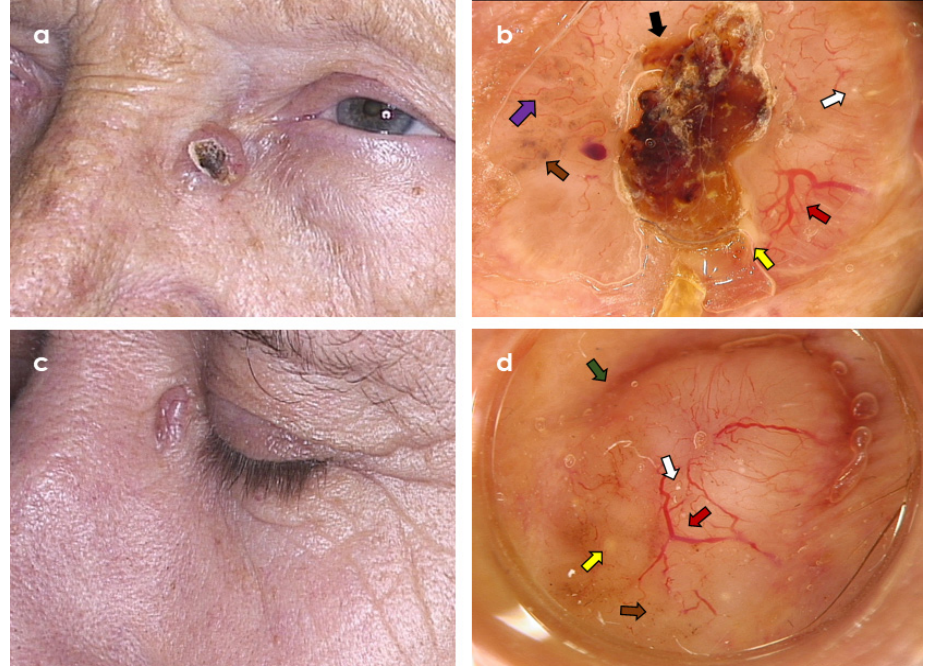
Figure 4. Two clinically similar tumours in the area of left medial eye canthus. ( a , b ) Trichoepithelioma; dermoscopy shows branched (arborizing) vessels (red arrow), superficial fine telangiectasia (violet arrow), central ulceration (black arrow), brown dots and globules (brown arrow), yellow globules (yellow arrow), and starry milia-like cysts (white arrow) (Fotofinder Vexia; Camera Medicam 800 HD, ×20 magnification). ( c , d ) Nodular basal cell carcinoma; dermoscopy shows branched (arborizing) vessels (red arrow), brown dots (brown arrow), starry milia-like cysts (white arrow), yellow globules (yellow arrow), and peripheral brown structureless areas (green arrow) (Fotofinder Vexia; Camera Medicam 800 HD, ×20 magnification). 3.3. Diagnostic Algorithm The binary classification algorithm managed to reach 79.23% AUC (95% CI: 69.69– 88.76%) on the randomly selected independent test set. The detailed ROC curve is presented in Figure 5a. While the general performance of the algorithm is good, its clinical utility remains low. When discriminating between malignant and benign tumours, usually a very high sensitivity is preferred, since the cost of false negative is significantly higher than the cost of false positive. Predicted classification scores are depicted in Figure 5b. There is a clear separation between the groups; however, it was not possible to determine a cut-off level, which would assure close to 100% sensitivity, while retaining relatively high specificity. Information from dermoscopic evaluation seems to be insufficient for the reliable and clinically useful discrimination between TT and BCC. The most important features of the model were presence of ulceration, age, maximum size, and the presence of cloudy/starry milia-like cysts. The detailed feature importance is presented in Figure 5c. The overview of the model is presented in Figure 5d.